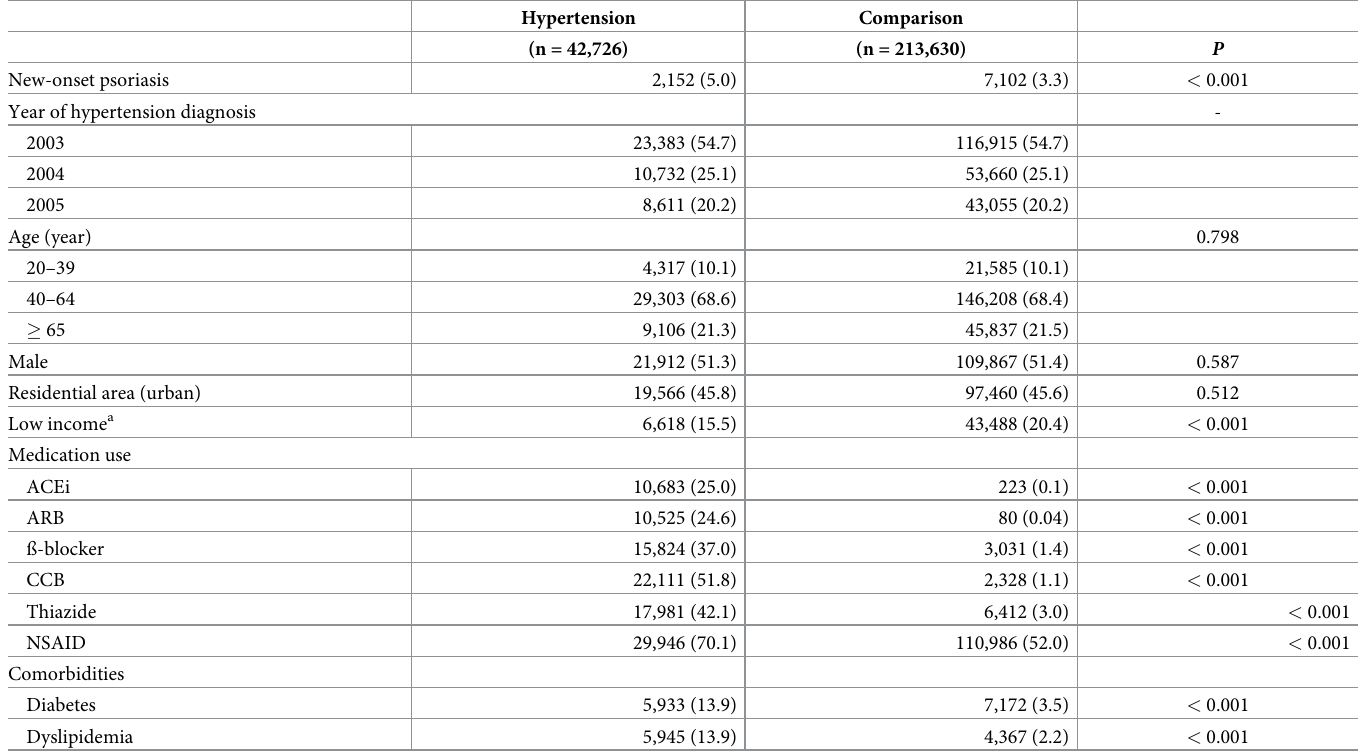
Table 1. Characteristics of the study